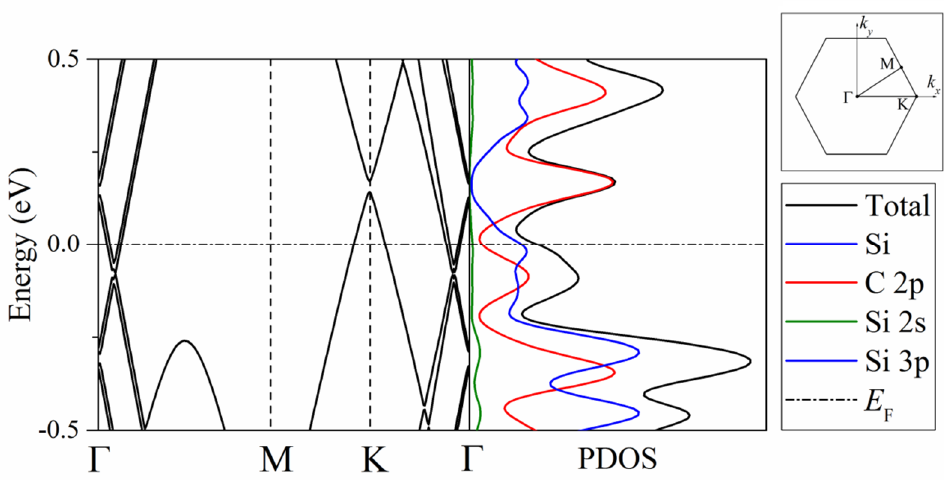
Figure 6. Band structure and partial spectra of electronic states of the “silicene on bilayer graphene” system; the Fermi level is indicated by a horizontal dashed line; the Brillouin zone for graphene with high symmetry points is shown in the inset at the top right.